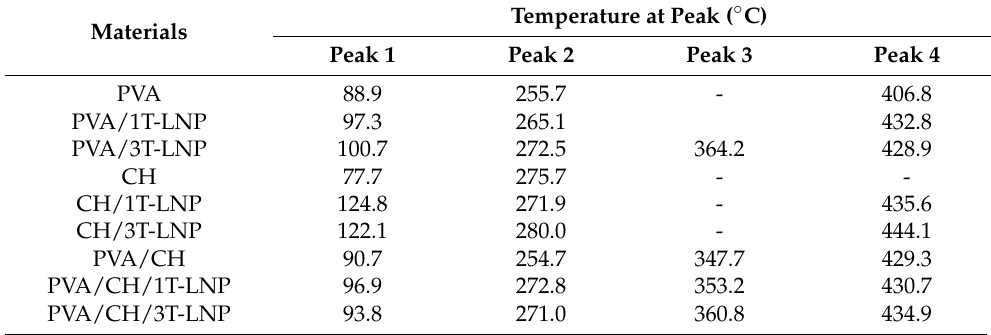
Table 8. Detailed DTG parameters for PVA, CH and LNP composited